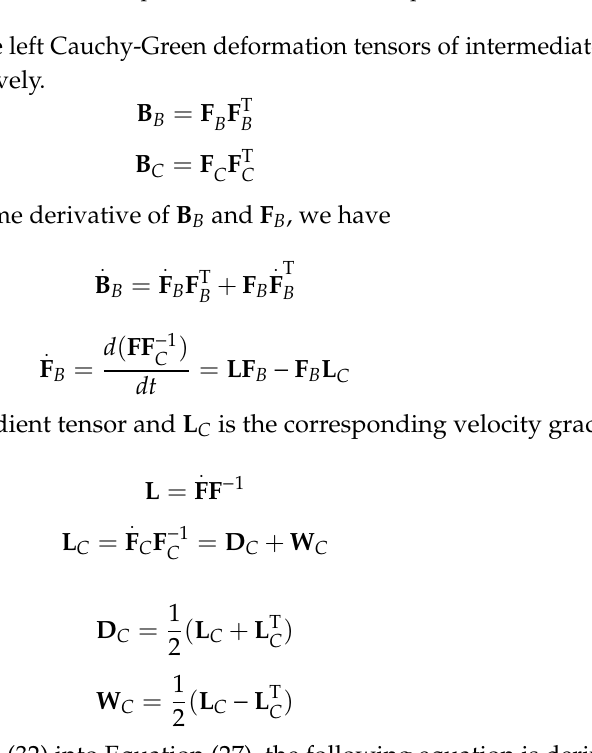
Figure 4. Illustration of multiplicative kinematics decomposition of F .